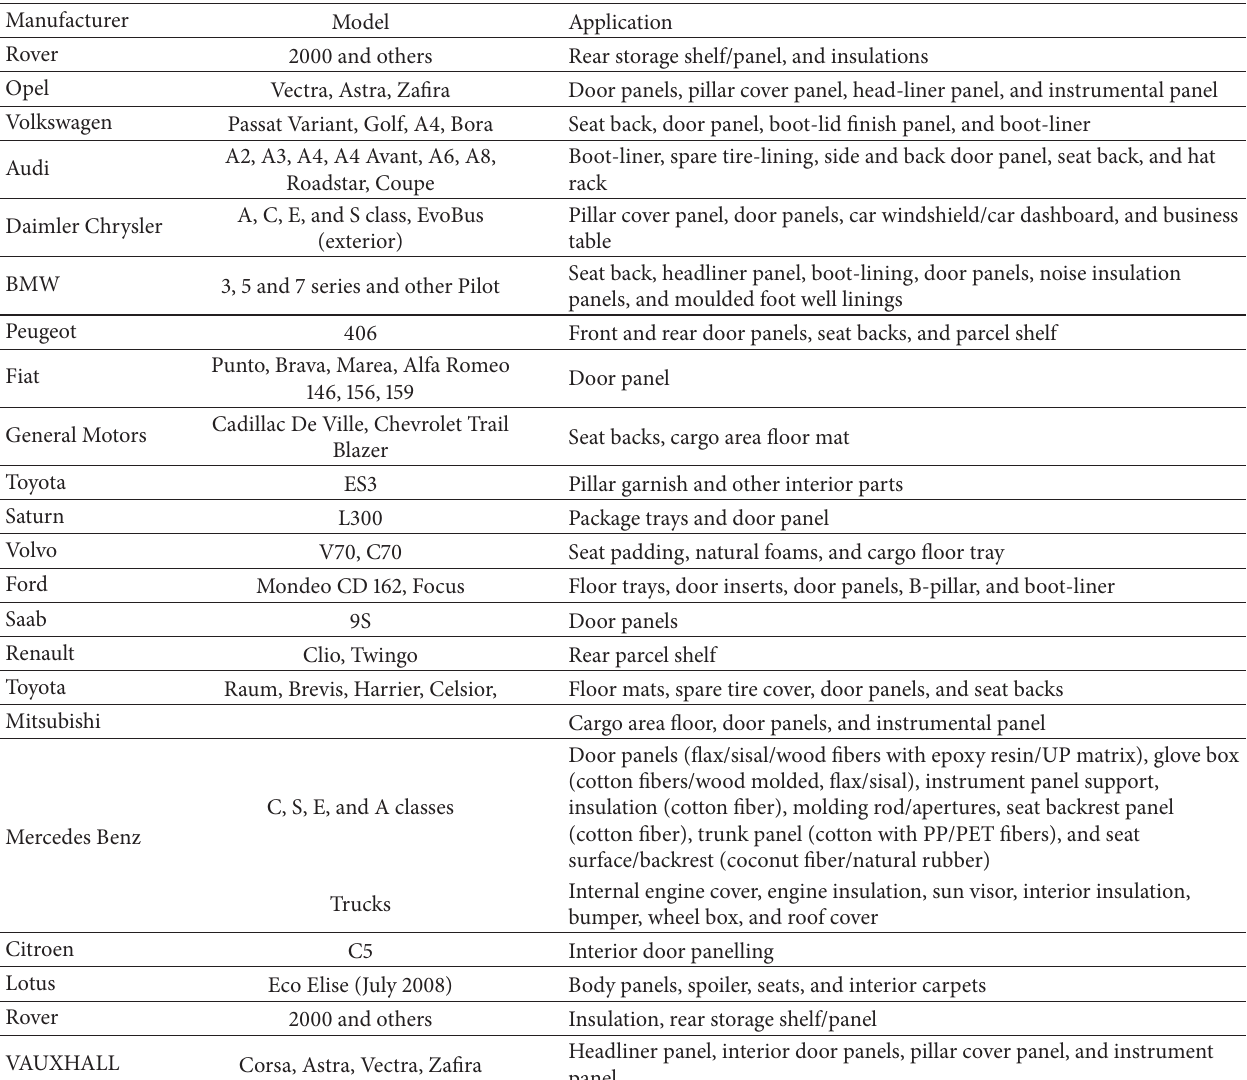
Table 5: The application of natural fiber composites in automotive industry